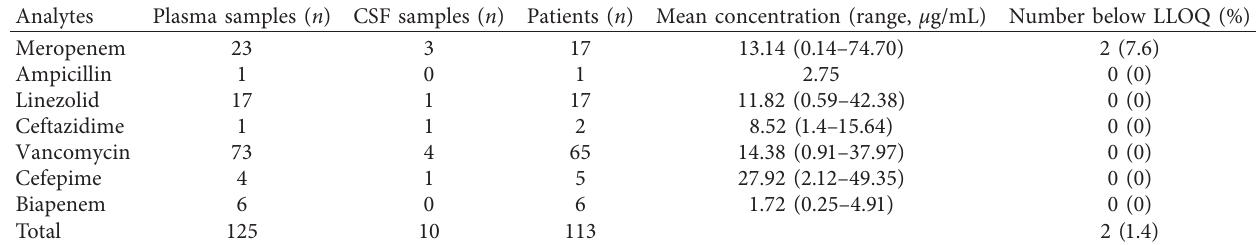
Table 5: Results of the measurement of antibiotics from patients’ samples.